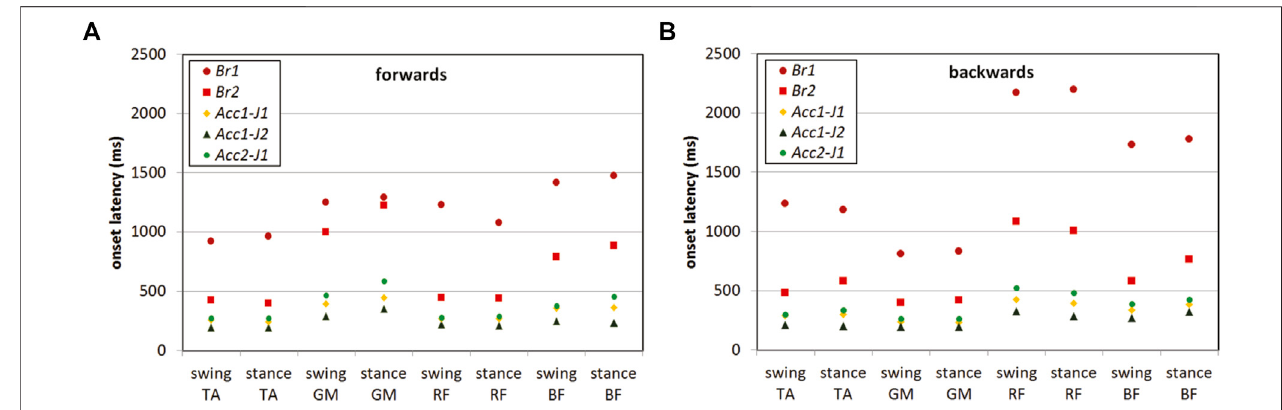
FIGURE 4 | Average EMG onset latencies for the muscles of the swing leg and the stance leg for each pulse type in forward (A) and backward (B) direction; TA, tibialisanterior;GM,gastrocnemiusmedialis;RF,rectusfemoris;BF,bicepsfemoris.Inbothdirections,shorteronsetlatencieswereobservedintheaccelerationpulses, compared to the braking pulses. The shortest active muscle response was evoked by Acc1-J2 pulse.